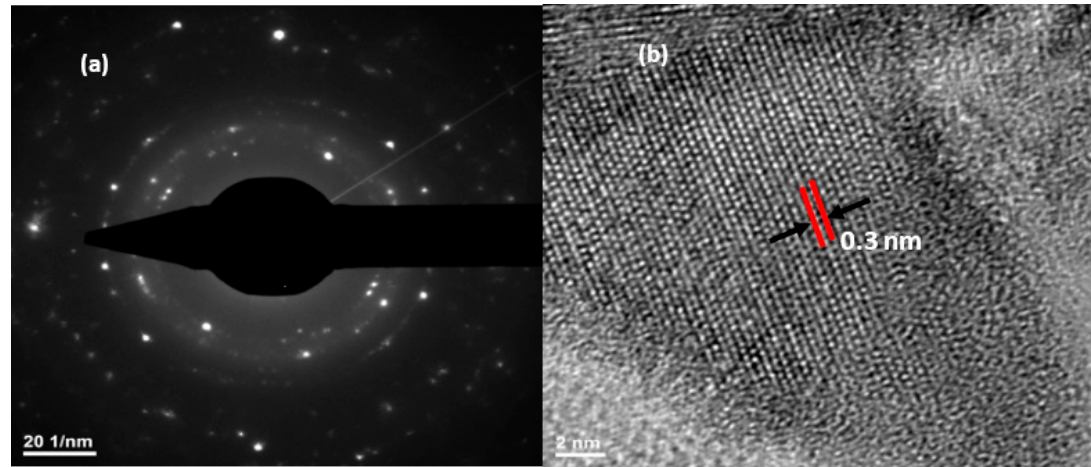
Figure 5. SAED pattern ( a ) and HRTEM image ( b ) of MoO 3 : Fe 2%-Co 1%.